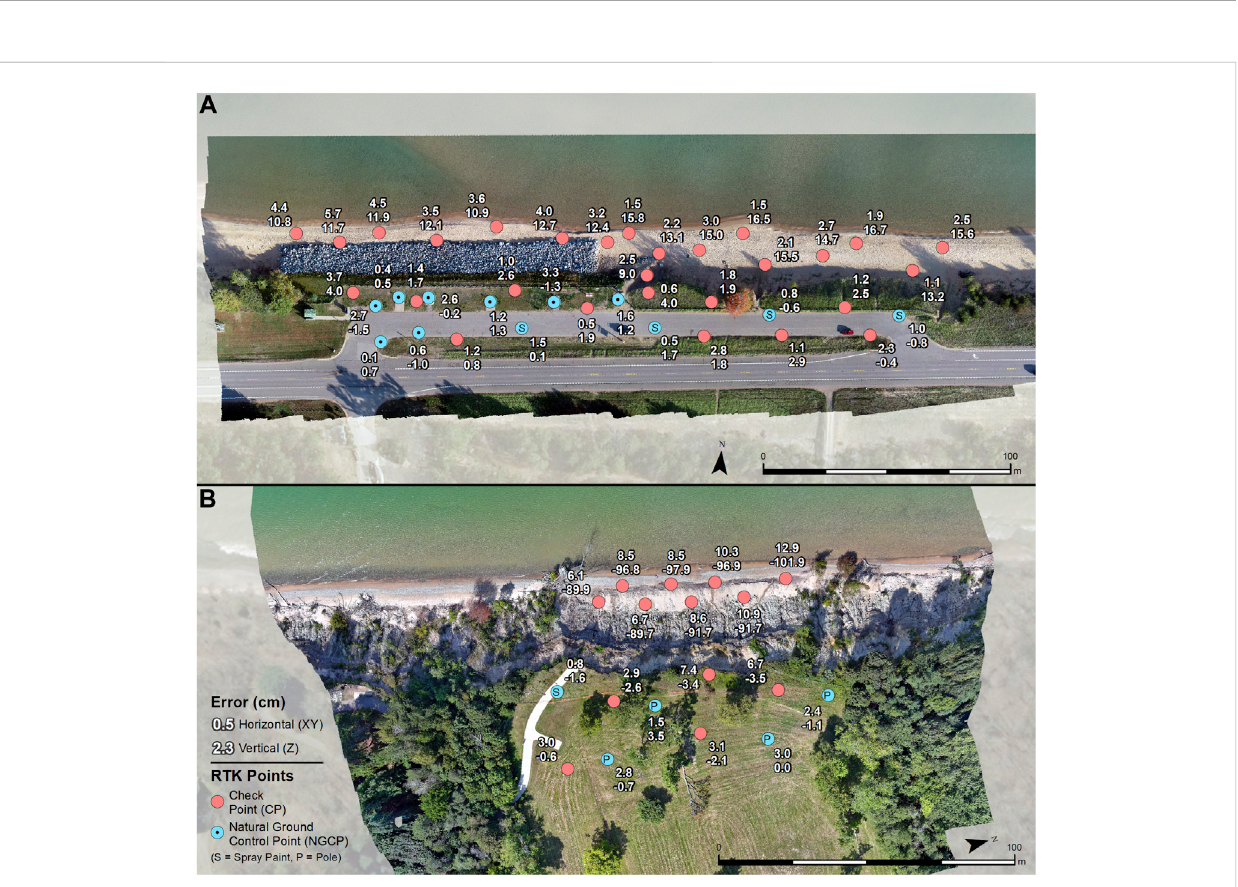
FIGURE 5 Check point (CP) and natural ground control point (NGCP) errors for sites with bluff morphology: Bluff-2 (A) and Bluff-1 (B) . Red points indicate CP locations andbluepoints indicateNGCPlocations.Semipermanentspraypainted NGCPsandsemipermanent NGCPsmountedonpolesarerepresented with an “ S ” and “ P ” respectively. Upper point labels show Horizontal (XY) error and lower labels show vertical (Z) error in